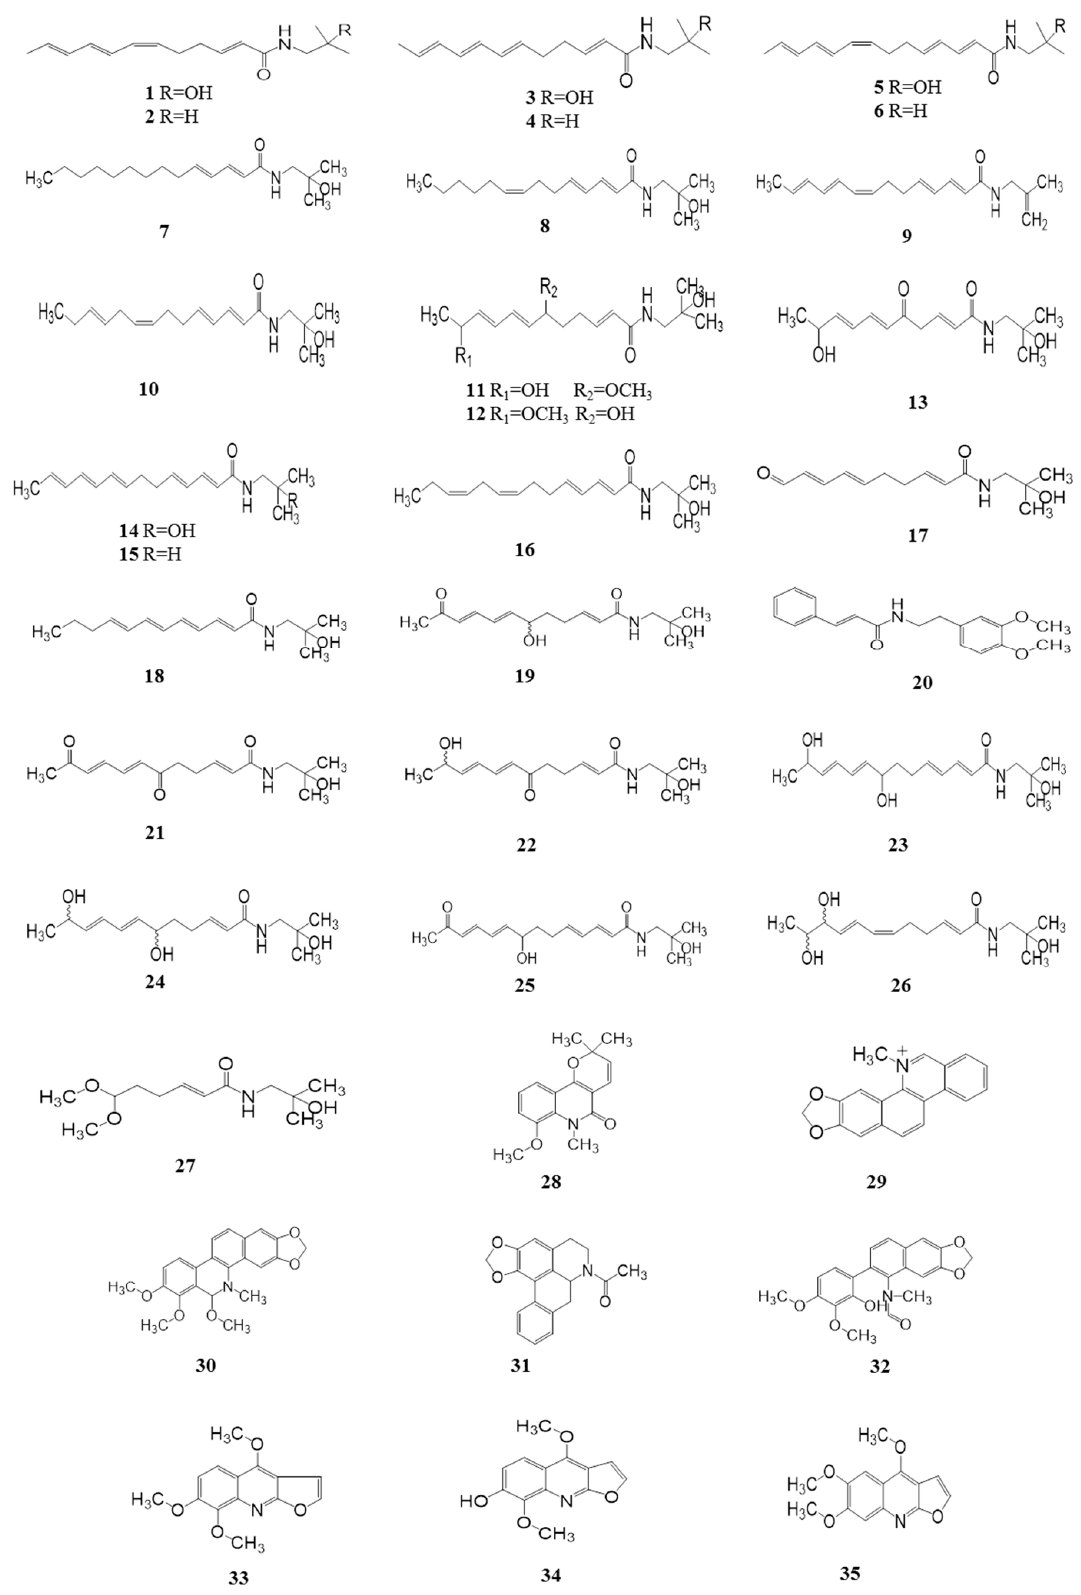
Figure 3. Chemical structures of alkaloids in Z. bungeanum .